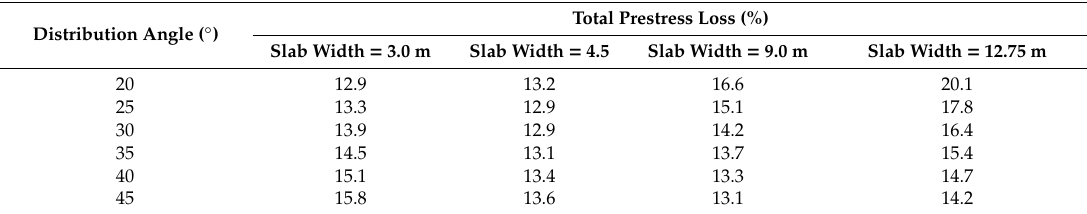
Table 7. The total prestress loss of BFRP